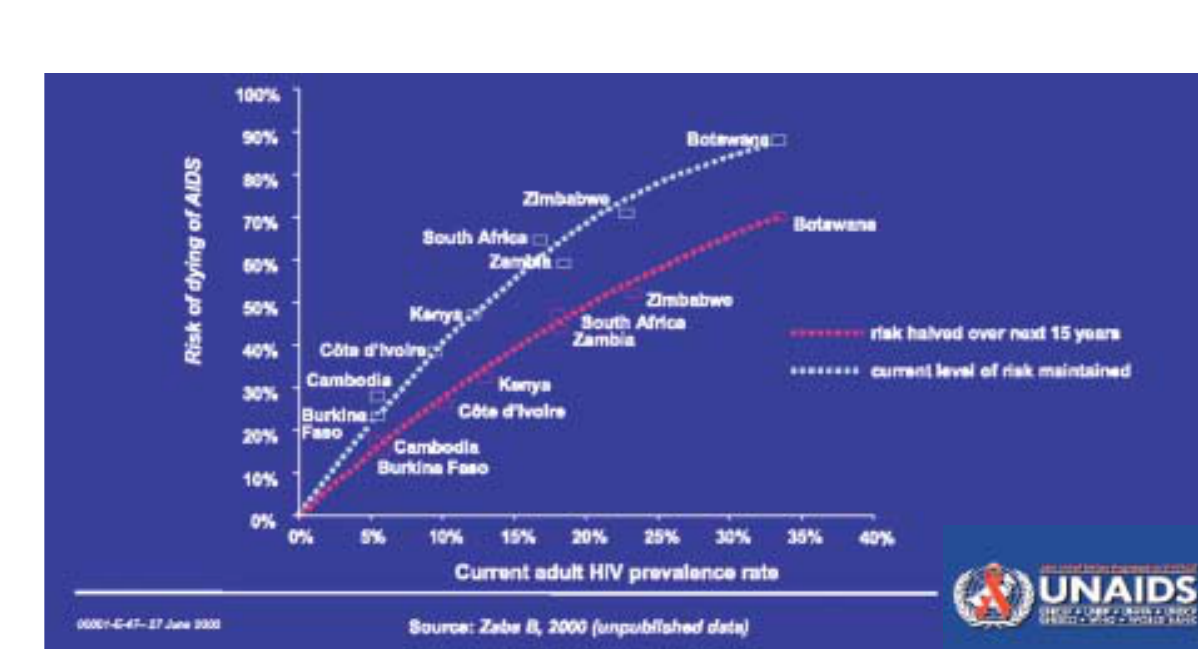
Fig. 2. Lifetime risk of AIDS death for 15-year-old boys, assuming unchanged or halved risk of becoming infected with HIV, selected